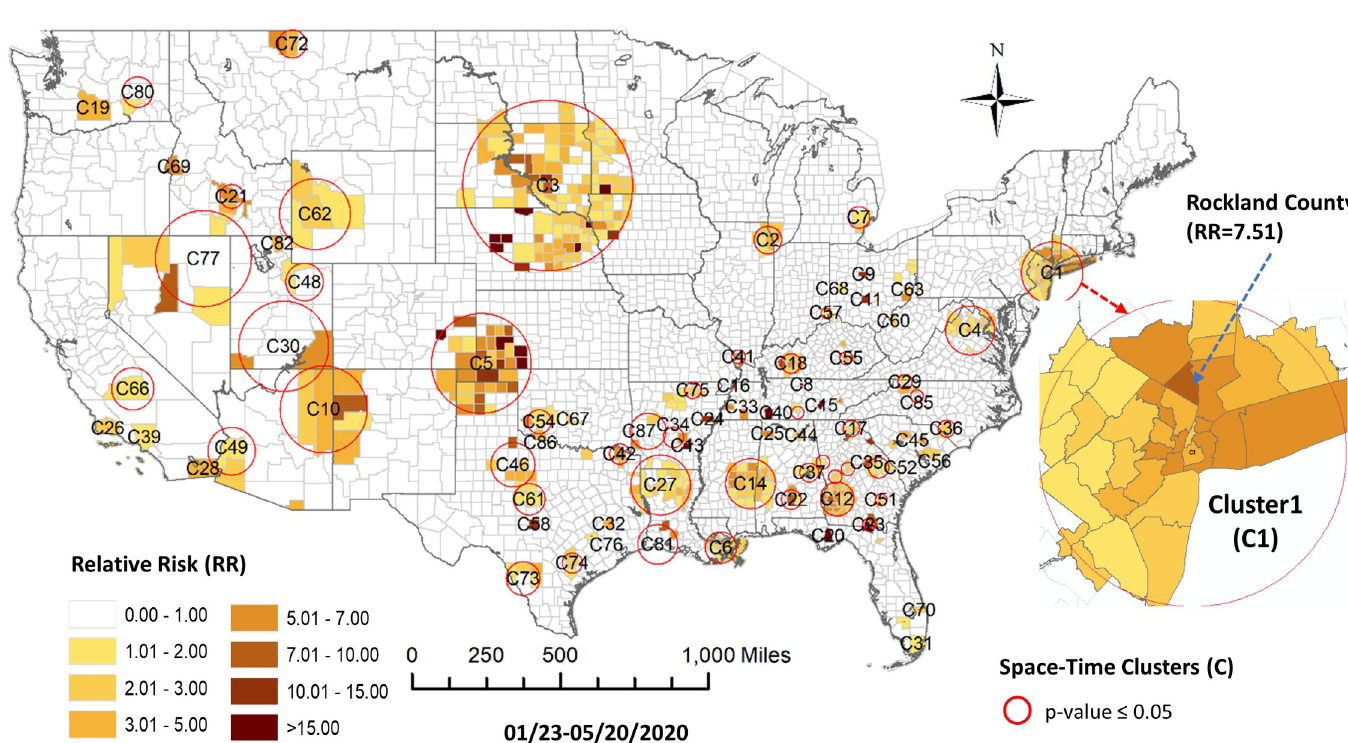
Fig 10. Prospective space-time scan statistic detected clusters of COVID-19 incidents during the study period of 1/22/2020-5/20/2020.